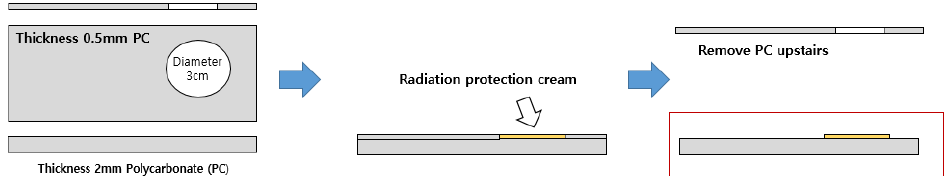
Figure 1. Thickness control plate of protective cream to evaluate shielding performance.